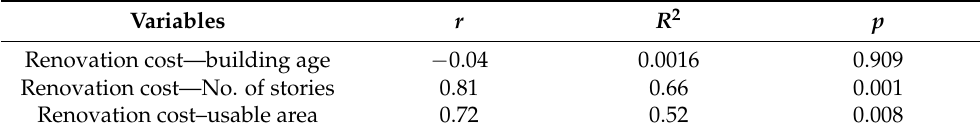
Table 1. Correlation